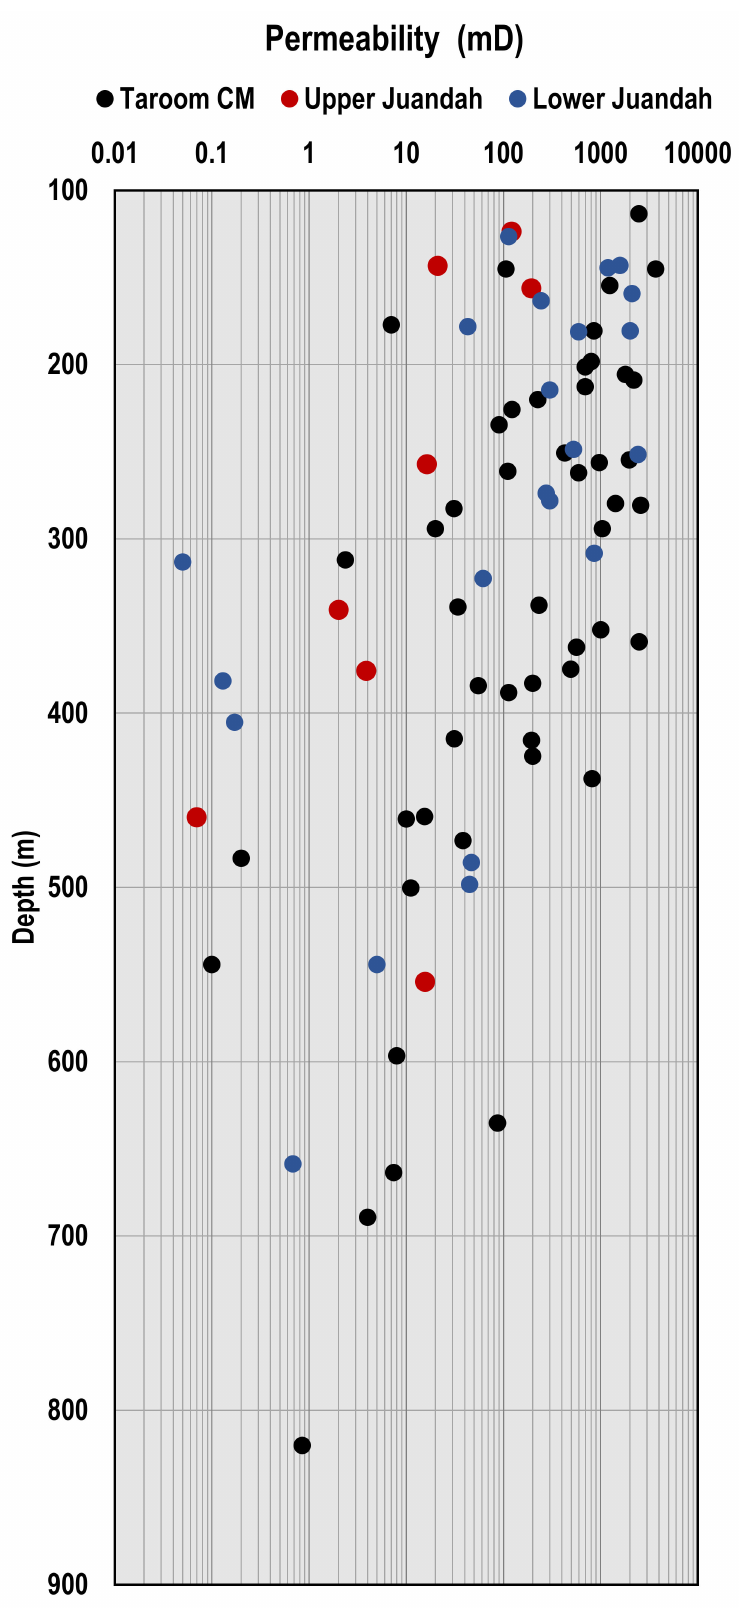
Figure 16. Permeability versus depth in the Surat Basin, QLD